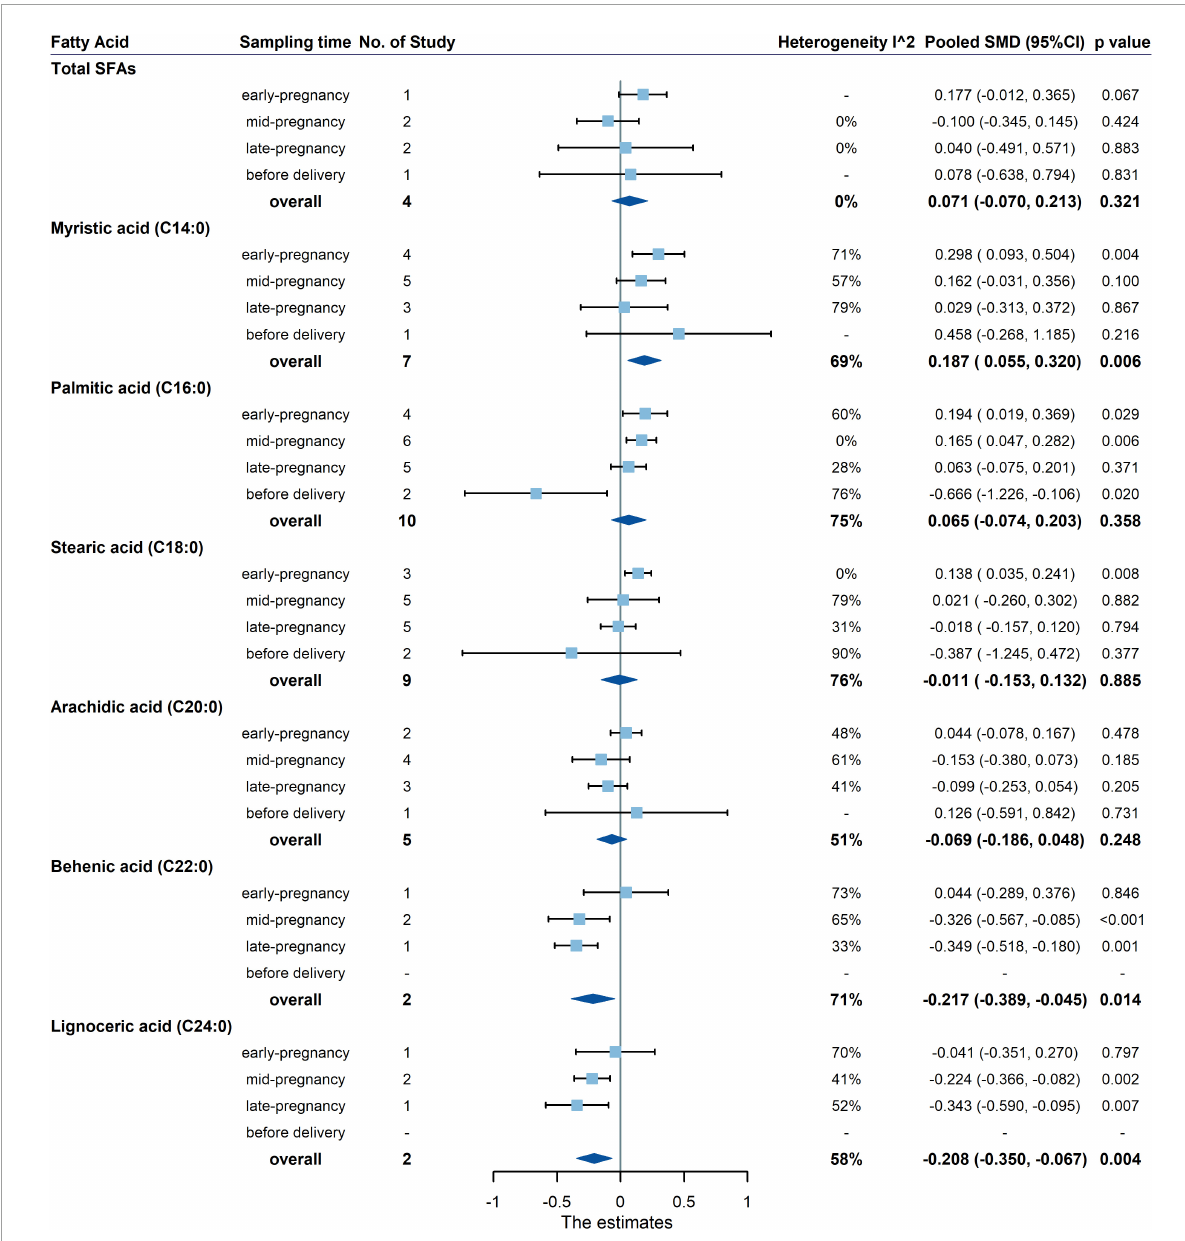
FIGURE4 Summary forest plot of pooled SMDs for total SFAs and each SFA as concentration in pregnant women with and without GDM. Dots and horizontal lines represent SMDs and 95% CIs. Diamonds depict pooled estimates. The forest plots of the original studies were shown in the Supplementary Figure 3